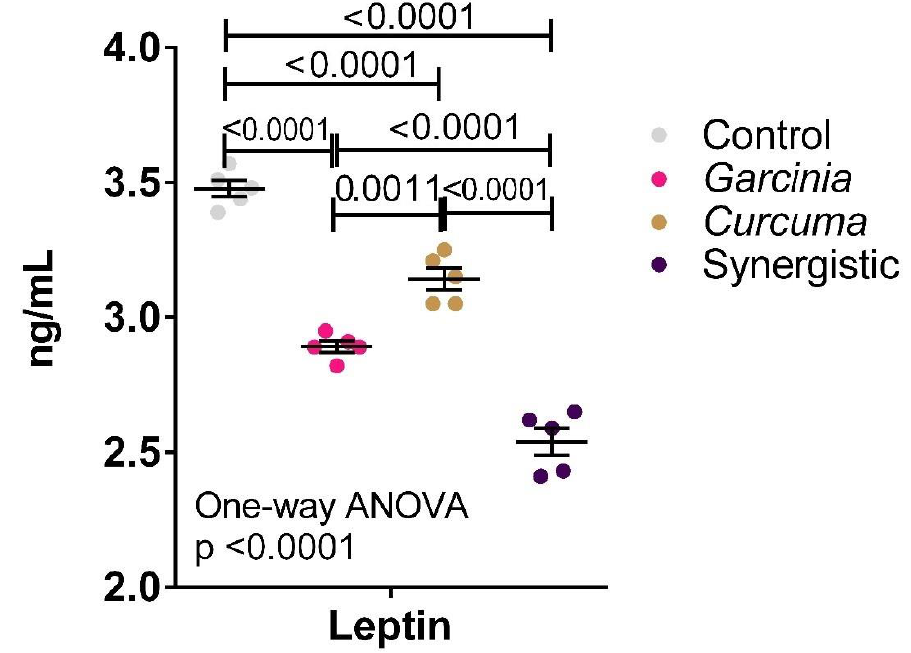
Figure 1. Independent and synergistic effects of C. longa and G. mangostata extracts on serum IL-6 and IL-12 in lean and HFT-induced obese rats. The mean and SEM are indicated in black. Significance was determined using a one-way ANOVA with a Tukey post-hoc test. ns: not significant.